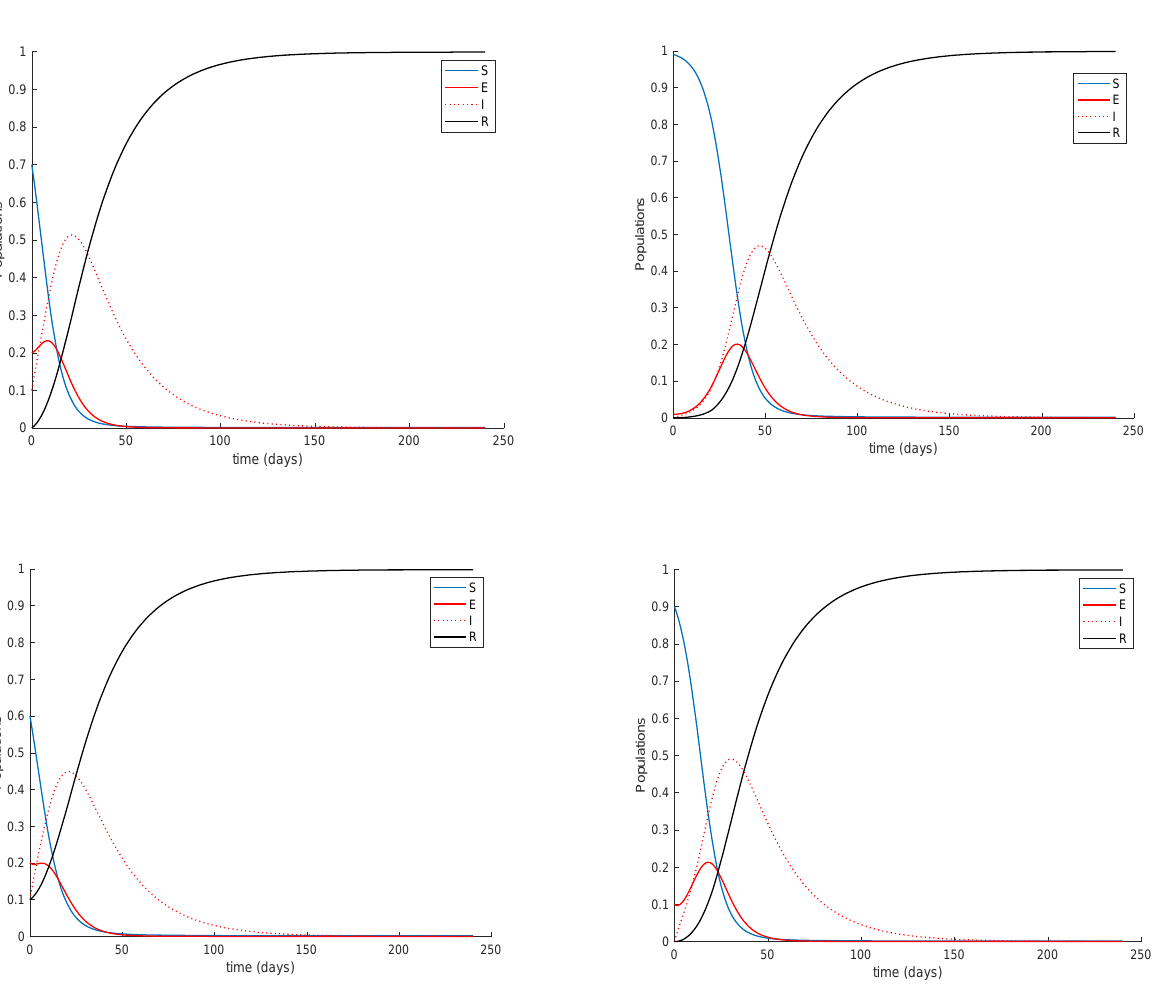
Figure 9. Dynamics of the model for different initial conditions and K = 0.001.